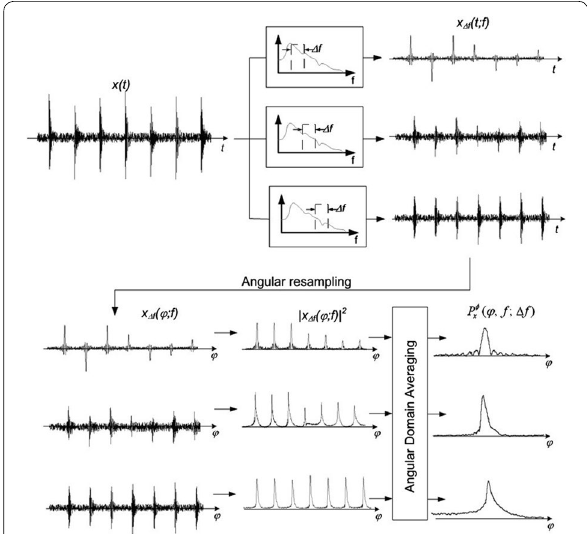
Figure 12 Aero-engine rotor test-bed Figure 13 Flow chart for calculation of the averaged